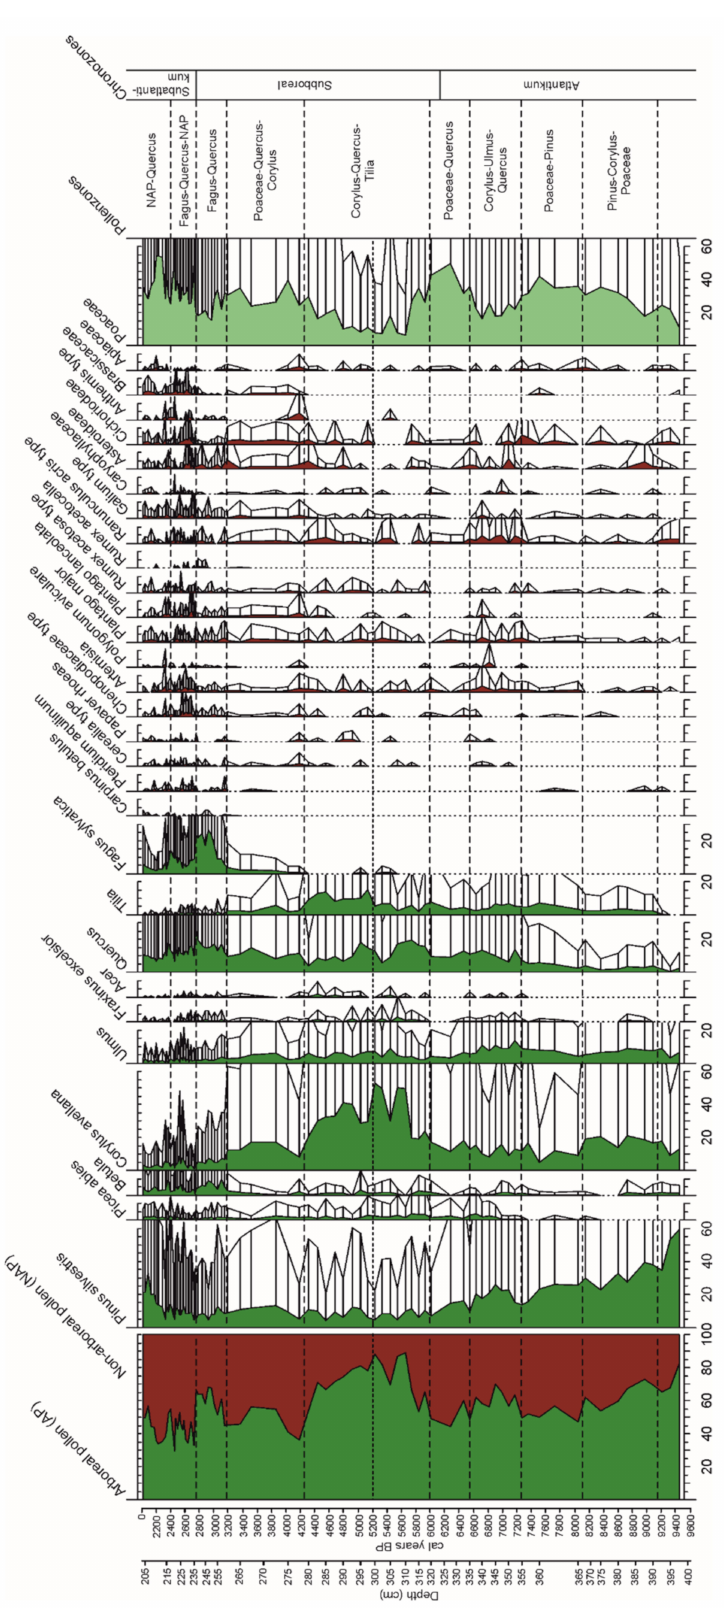
Figure 4. Pollen diagram